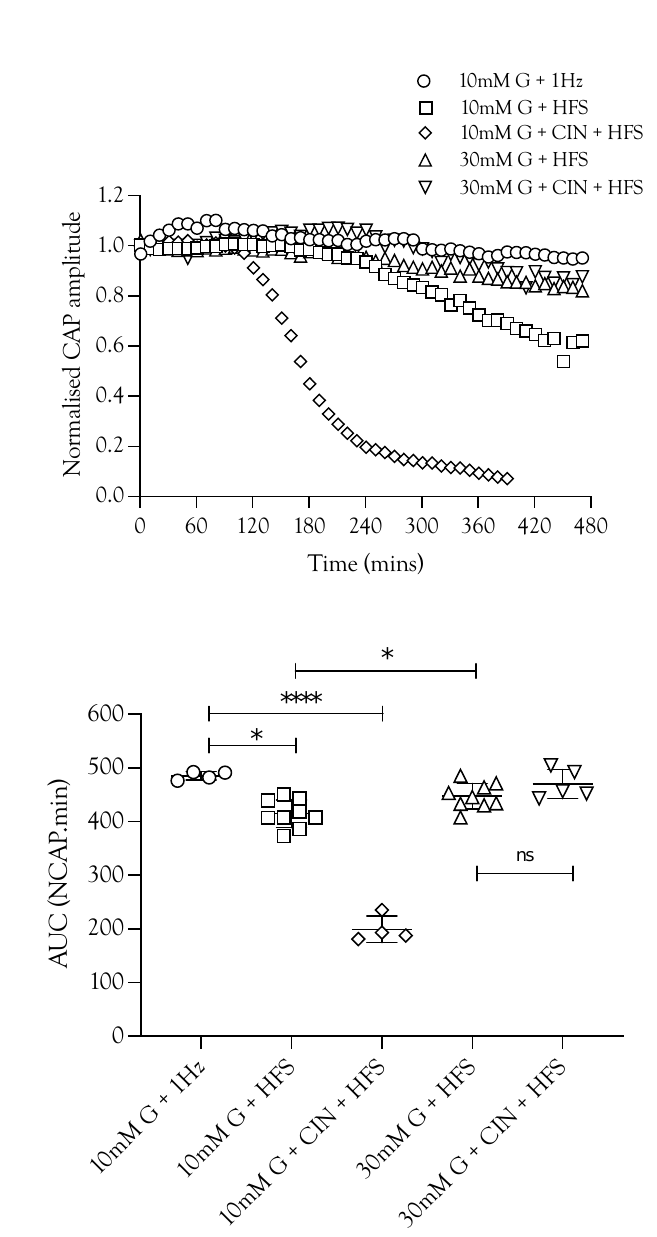
Figure 2. The increased energy demand placed on the sciatic nerve by HFS was met by increased energy substrate supply. ( A ). The A fibre CAP was fully supported in 10 mM glucose but decreased when exposed to HFS. However, increasing the glucose from 10 mM to 30 mM in nerves exposed to HFS increased the maintenance of the CAP. The addition of 200 µ M CIN during 10 mM glucose and HFS resulted in accelerated failure of conduction with both reduced latency to failure onset (approximately 2 h compared to 4 h) and increased rate of failure. ( B ). Increasing the stimulus frequency under normoglycaemic conditions (10 mM glucose) reduced the maintenance of conduction from 485.4 ± 7.6 NCAP.mins ( n = 3) to 414.9 ± 26.0 NCAP.mins ( n = 9). The CAP was increased when the 10 mM glucose was replaced with 30 mM glucose (447.2 ± 23.8 NCAP.mins, n = 9), but addition of CIN had no effect on the CAP area (469.9 ± 27.0 NCAP.mins, n = 5). The addition of CIN reduced the latency to CAP failure in nerves perfused with 10 mM glucose and exposed to HFS (199.3 ± 24.5 NCAP.mins, n = 4) (**** = p ≤ 0.0001, * = p ≤ 0.05, ns = not